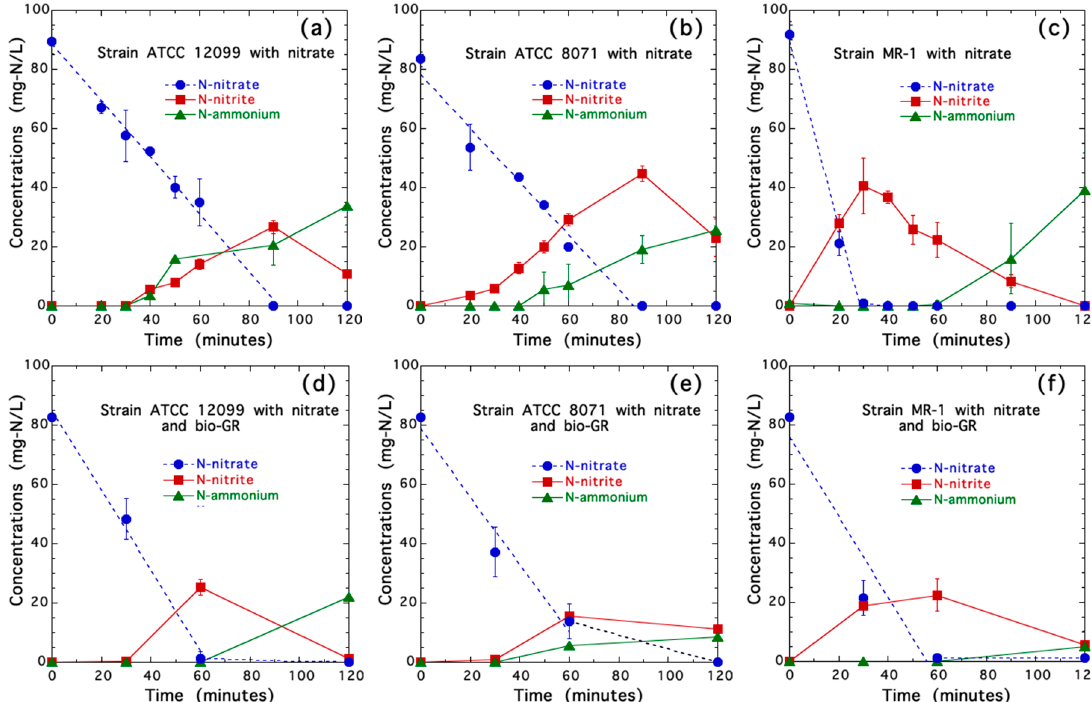
Figure 3. Comparison of nitrate reduction by S. putrefaciens ATCC 12099 ( a,d ), S. putrefaciens ATCC 8071 ( b,e ), and S. oneidensis MR-1 ( c,f ) in the absence ( a – c ) or presence ( d – f ) of biogenic Fe(II-III) hydroxycarbonate green rust, here referred to as “bio-GR”. All experiments were carried out in triplicate, except for those performed with strains ATCC 12009 and ATCC 8071 in the absence of bio-GR, which were in duplicate. Error bars correspond to standard deviations of replicate experiments. Dashed lines correspond to initial rates of nitrate reduction calculated using a linear regression fitting procedure in the time interval between time zero and 90 min for ATCC 12099 and ATCC 8071, between time zero and 30 min for MR-1, and between time zero and 60 min for all experiments carried out in the presence of bio-GR. Solid lines correspond to the interpolation of experimental data of nitrite and ammonium.